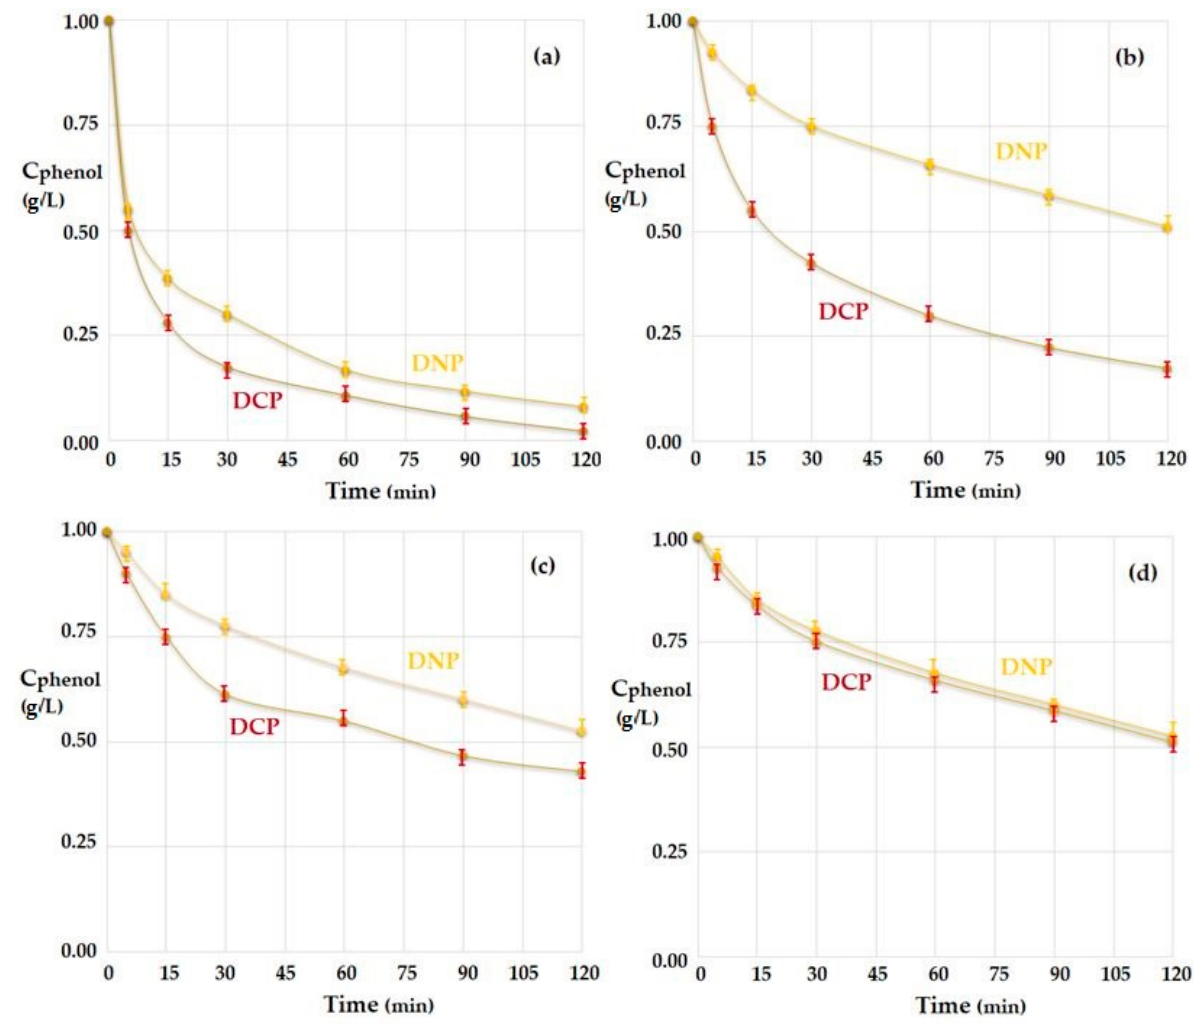
Figure 10. The decrease in concentration of 2,4–dinitrophenol (DNP) and 2,4–dichlorophenol (DCP) for operation with the glass spheres module (Gl), of a source phase with: pH = 2 ( a ); pH = 4 ( b ); pH = 6 ( c ); and pH = 8 ( d ); for a receiving phase with the same pH (pH = 13), for n –octanol membrane. Increasing the pH of the source phase to a value of 4, close to pK a 2,4–dinitrophenol (DNP), led to a half-attenuation of the decrease in the concentration of this compound (Figure 10b). Further increasing the pH of the source phase to 6 also affected the reduction of the concentration of the other phenolic compound, 2,4–dichlorophenol (DCP) (Figure 10c).